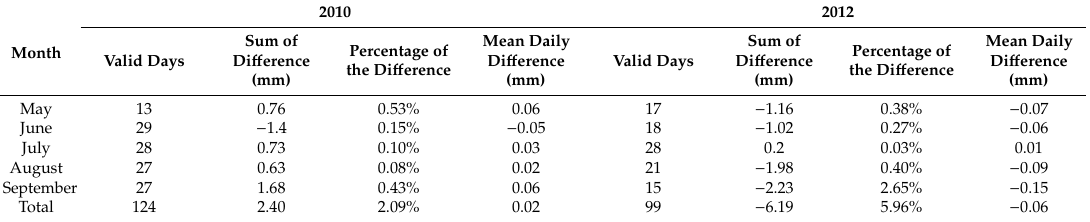
Table 3. Comparison between the calculated and measured daily T in di ff erent months.